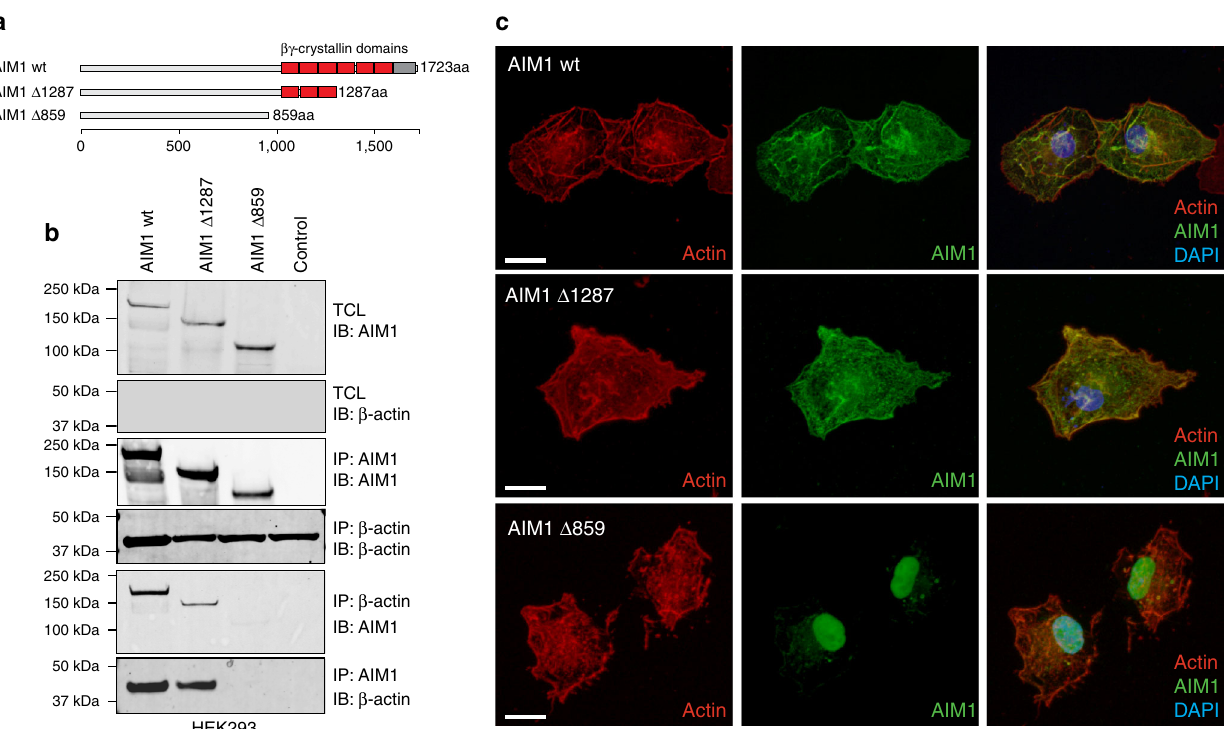
Fig. 2 The C terminus of AIM1 is required for the ef fi cient interaction of AIM1 with the actin cytoskeleton. a Ideogram depicting the domain structure of AIM1 and the C-terminal deletion constructs used in the study (wt, denotes wild-type AIM1; Δ 1287, indicates C-terminal deletion to amino acid 1287; Δ 859, indicates C-terminal deletion to amino acid 859). b Reciprocal co-immunoprecipitations of wt AIM1 and AIM1 deletion mutants in HEK293 cells demonstrate that the Δ 859 C-terminal deletion mutant, lacking all βγ -crystallin domains, fails to interact with the actin cytoskeleton, while full length and Δ 1287 AIM1 retain binding to the actin cytoskeleton. Immunoblots shown here are representative of three independent experiments. c Confocal immuno fl uorescence microscopy demonstrates strong co-localization of actin (visualized by alexa-568-labeled phalloidin, shown in red ) with YFP-tagged (shown in green ) wt and Δ 1287 AIM1 in transiently transfected COS7 cells. Scale bars indicate 5 μ m. AIM1 Δ 859 shows a predominant nuclear localization and no co-localization with actin. Two percent of TCL was loaded as control. IB immunoblot, IP immunoprecipitate, TCL total cell